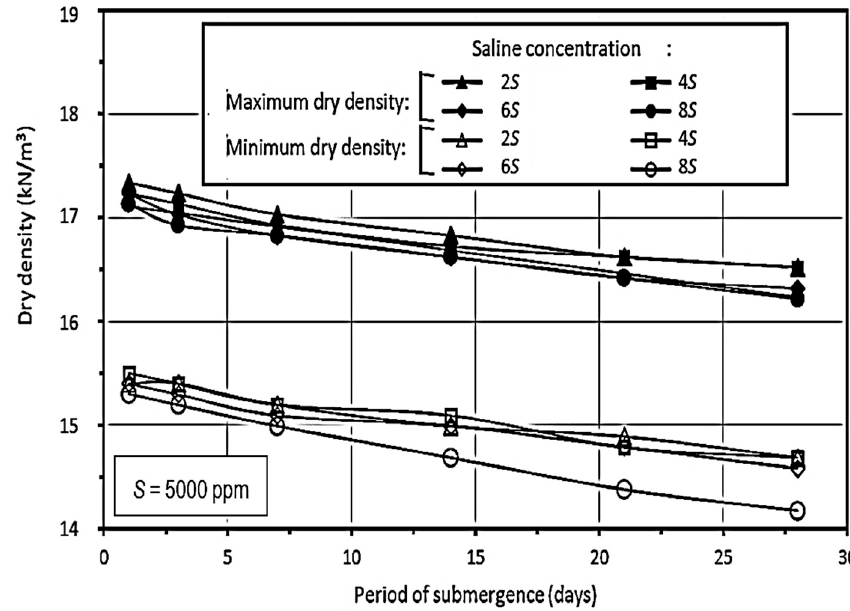
Figure 7. Variation of normalized dry density with period of submergence.